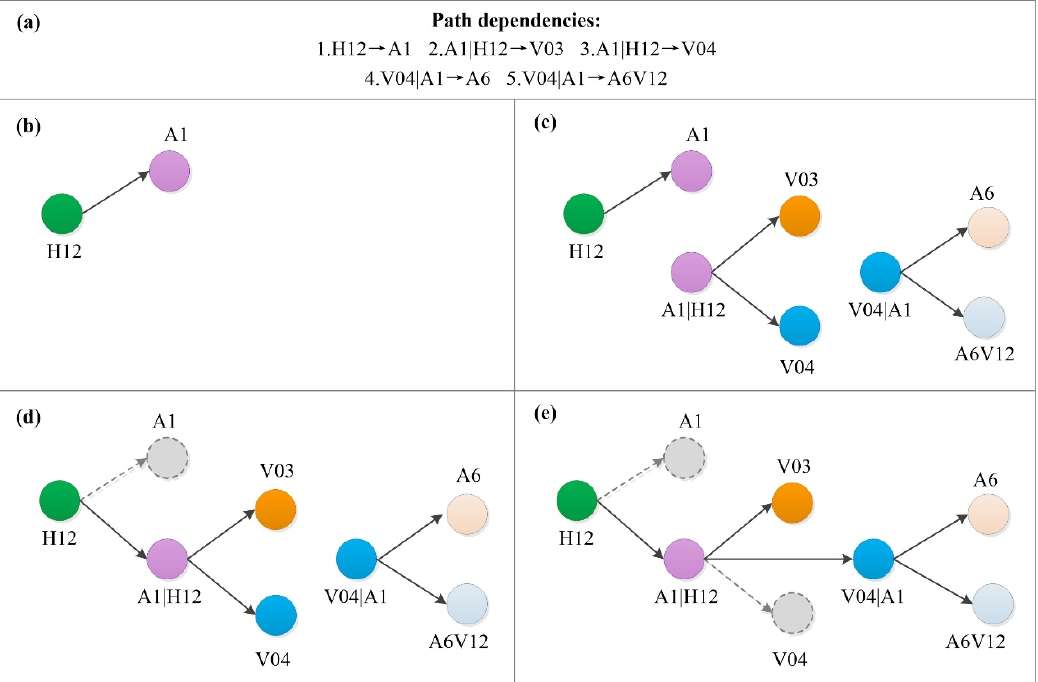
Figure 2. Network construction of HMTACN. ( a ) Path dependencies. ( b ) The first-order path dependency (H12 → A1) is converted into two first-order nodes (H12, A1) and their edges. ( c ) The higher-order path dependencies are converted into higher-order nodes and their edges. ( d ) Reconnect the higher-order node from H12 to A1|H12. ( e ) Reconnect the higher-order node from A1|H12 to V04|A1.